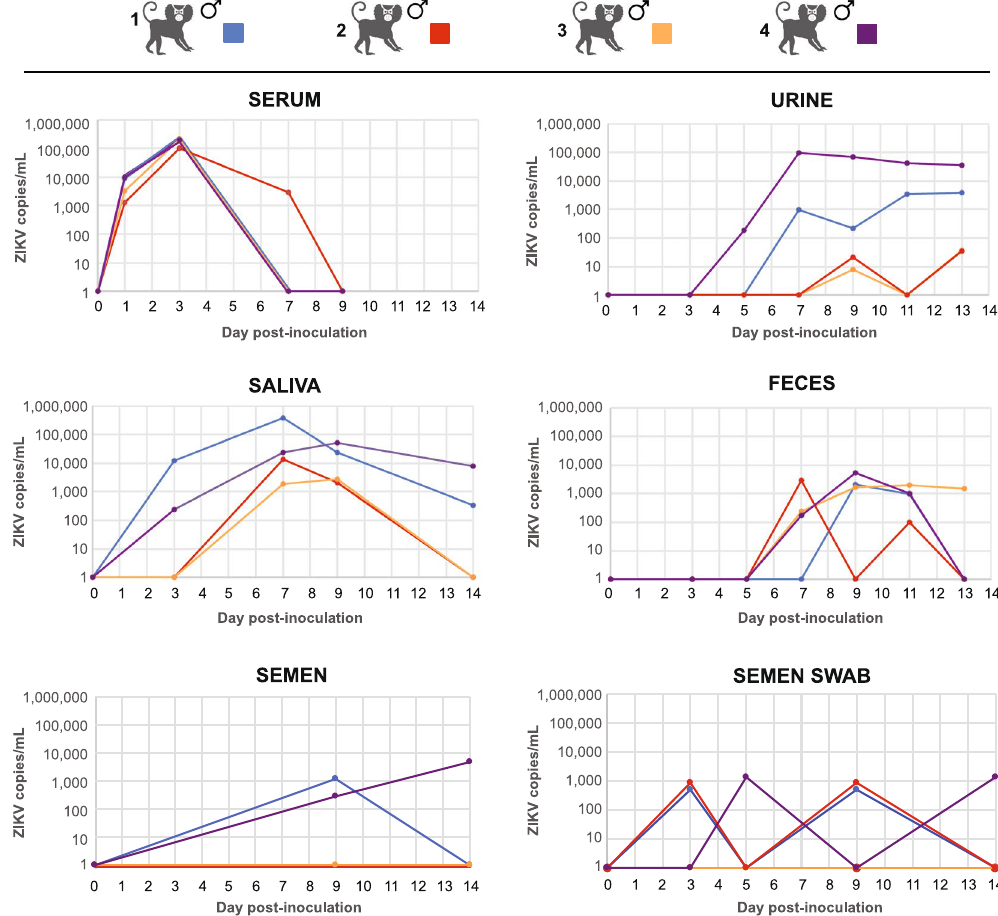
Figure 2. Viral loads in body fluids after acute ZIKV infection. The ZIKV load in copies per milliliter is plotted according to day post-inoculation. The line graph corresponding to each marmoset is displayed in a distinct color. Note that some lines are not visible in the serum graph due to similar viral load measurements that result in overlapping